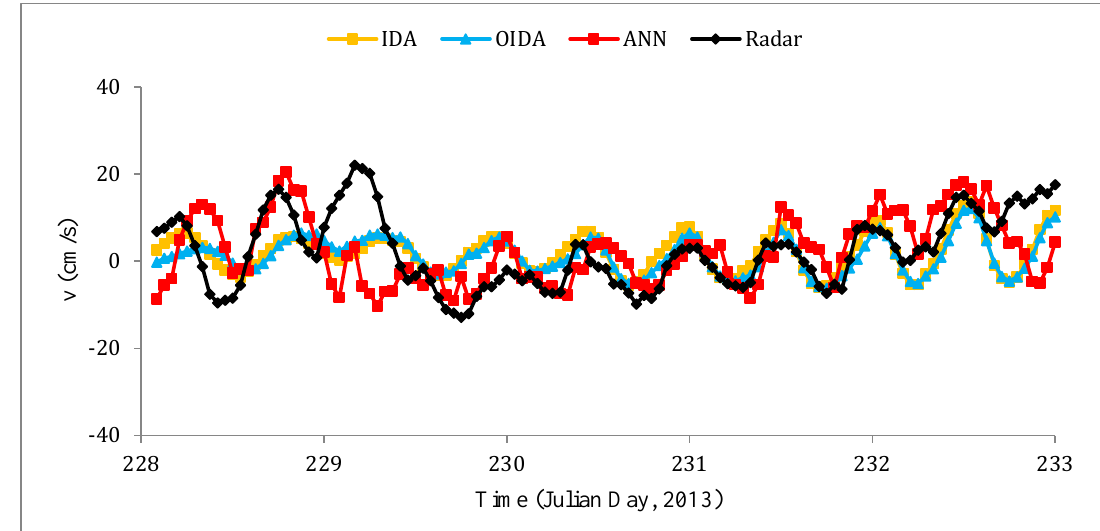
Figure 12. Forecasting of east–west velocity component at A3. IDA and OIDA indicate data assimilation using Optimal Interpolation and indirect correction method, respectively, the same convention of IDA and OIDA was used as follows. ANN indicates Model U17.